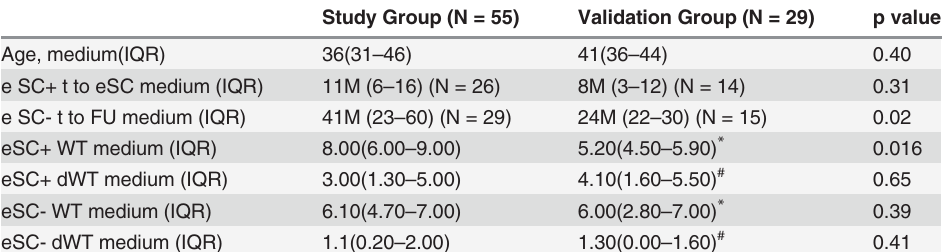
Table 7. The differences of clinical parameters and nodal manifestations between study and validation group.